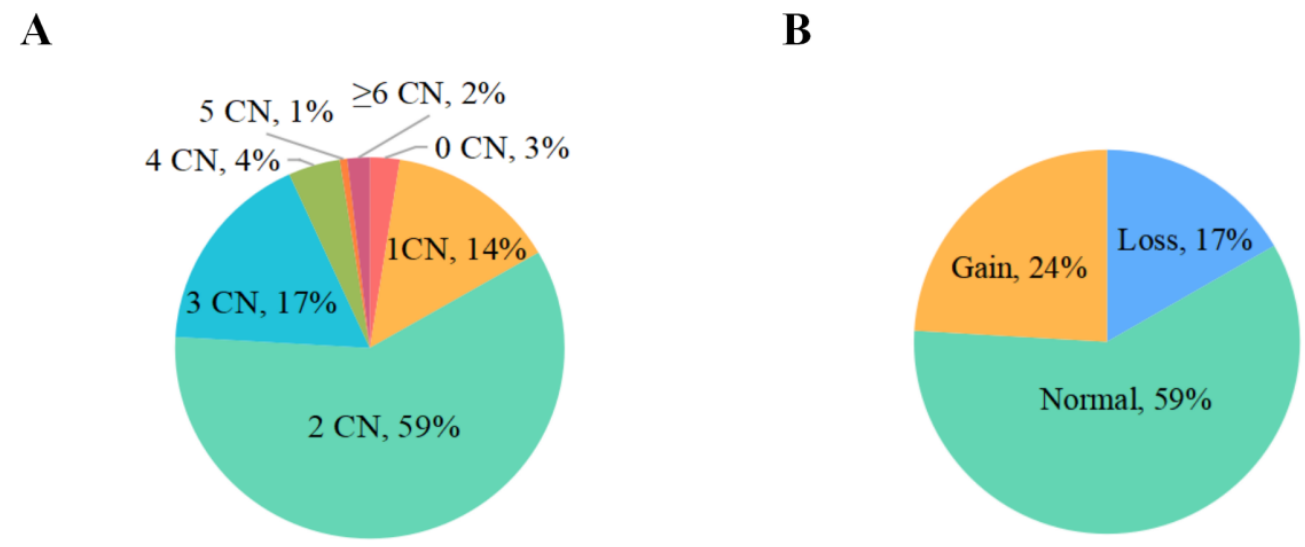
Figure 1. Distribution of copy number variation of the SNX29 in Xiangdong black goats. ( A ) The frequency of the copy numbers of the SNX29 CNV in Xiangdong black goats. The number of 0 to ≥ 6 represented the copy number (CN) of SNX29 CNV; ( B ) Distribution of different CNV types in Xiangdong black goats. Loss, Normal, Gain was defined as copy number <2, =2, or >2, respectively.